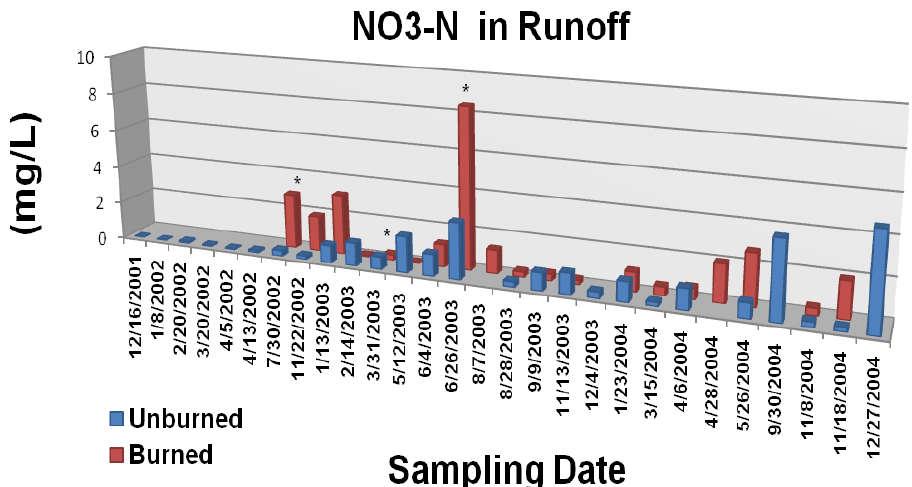
Figure 6B. Mean nitrate N concentrations in overland/litter interflow runoff from unburned and wildfire burned study plots. The Gondola wildfire occurred July 3, 2002. Significant differences are noted as p <0.10 (*), p <0.05 (**), or p <0.01 (***). Adapted from